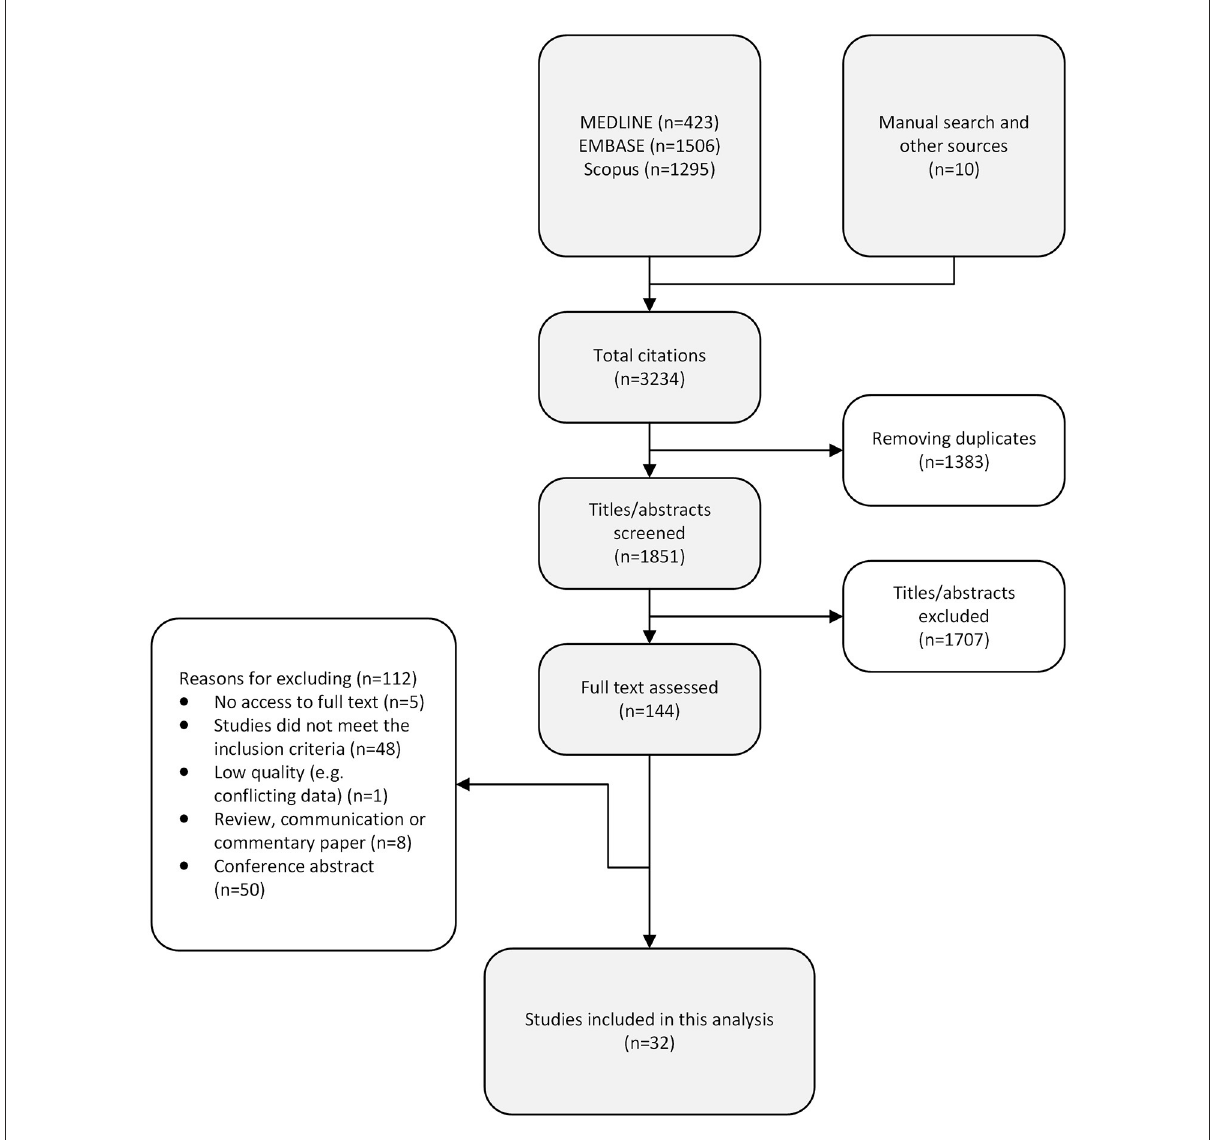
FIGURE2 Flowchart of study identification and selection.